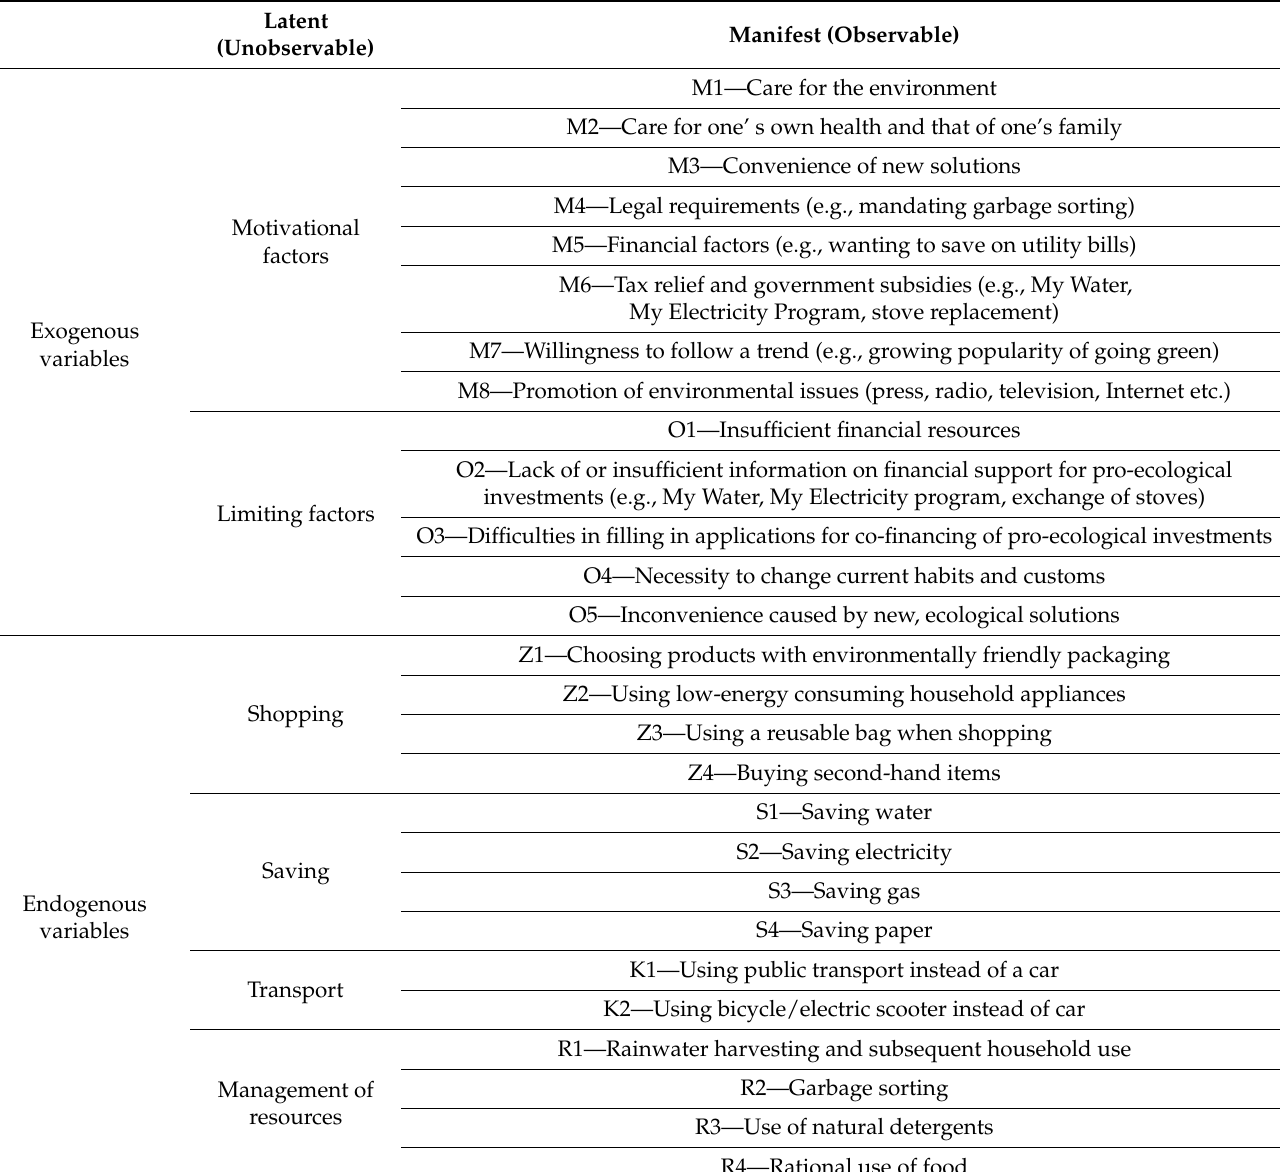
Table 9. Specification of latent and manifest variables in Model I and Model